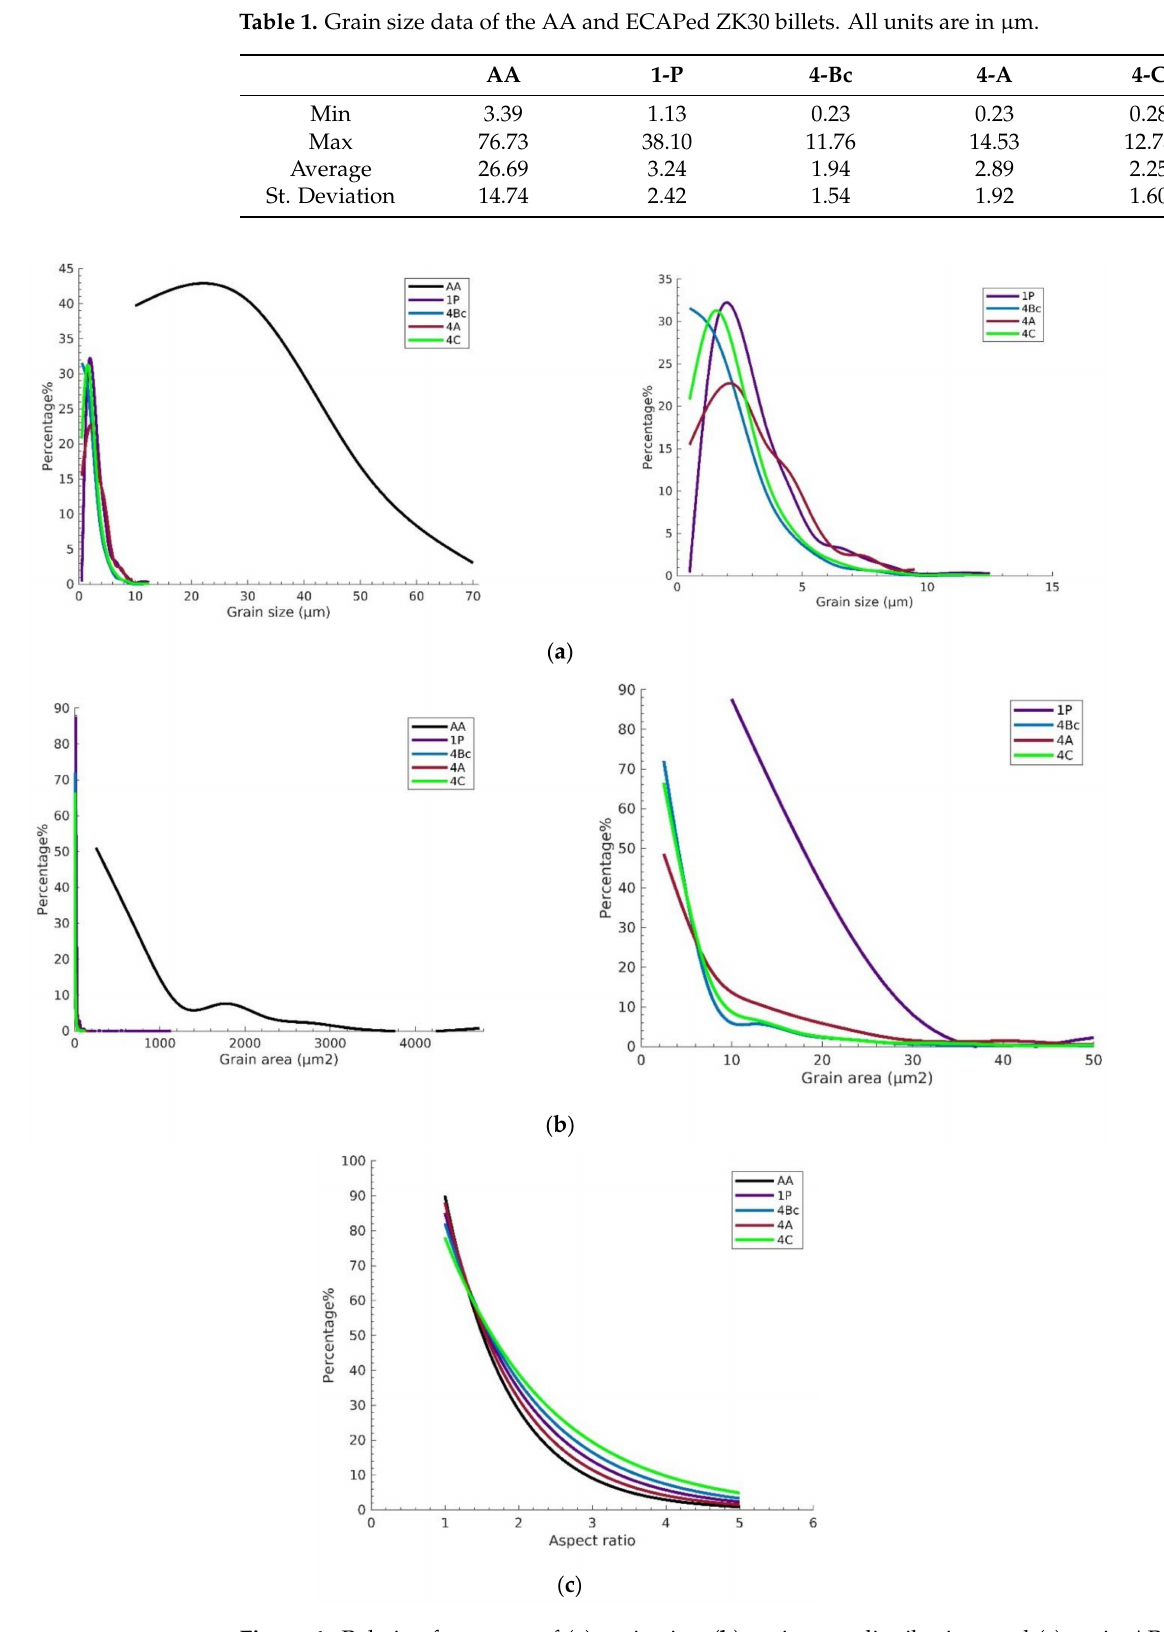
Figure 4. Relative frequency of ( a ) grain size, ( b ) grain area distribution, and ( c ) grain AR of all ZK30